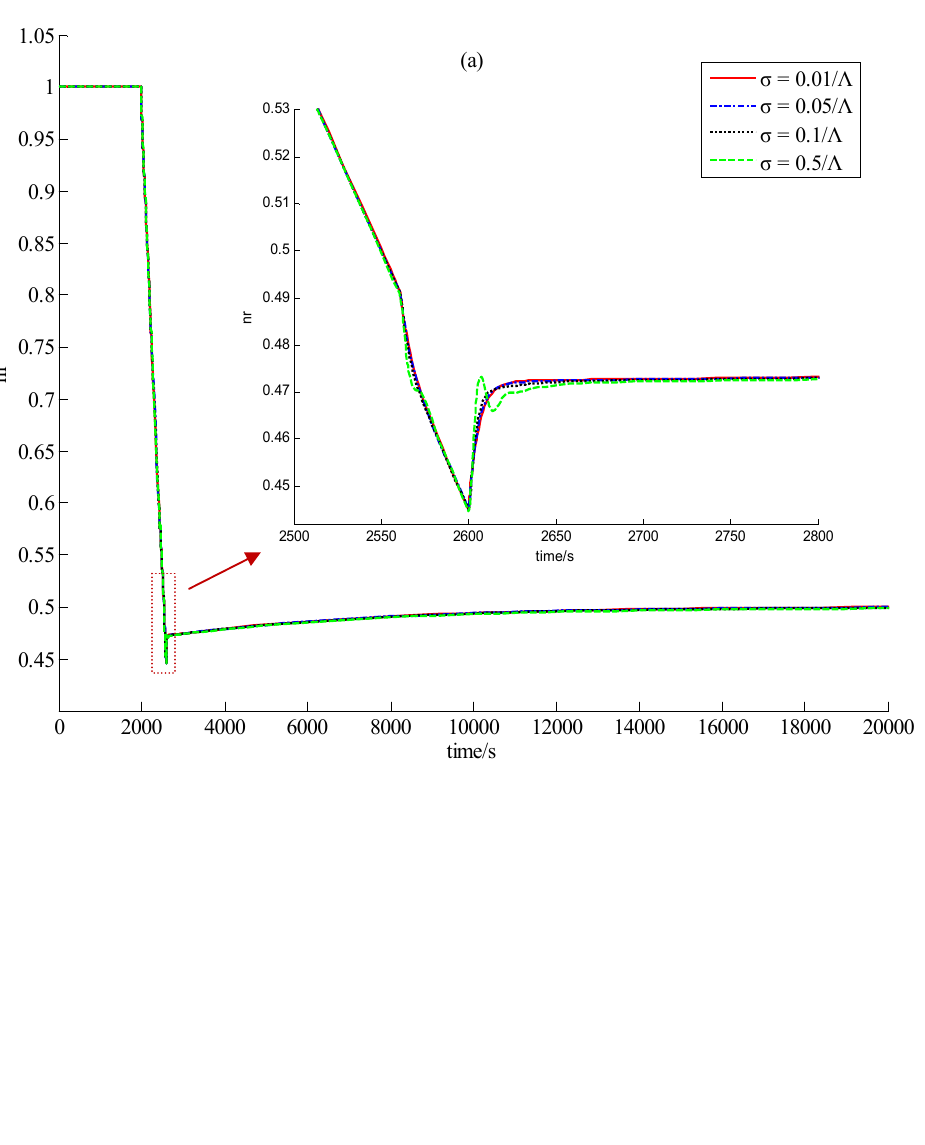
Figure 3. Dynamic responses in Case A of ( a ) relative nuclear power; ( b ) average fuel temperature; ( c ) outlet helium temperature and ( d ) control rod speed signal with different σ and constant ε